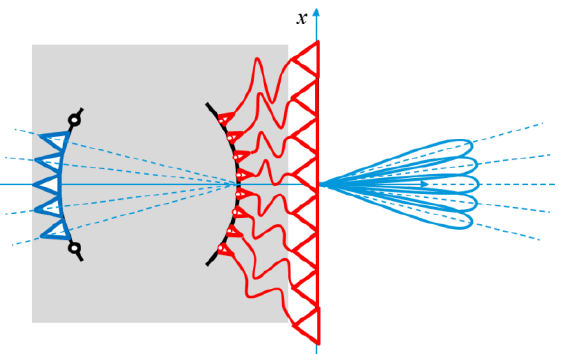
Figure 4. Bootlace lens with back array smaller than the front array. It exhibits a significant saving in terms of volume and a reduced field of view as compared to the back lens.